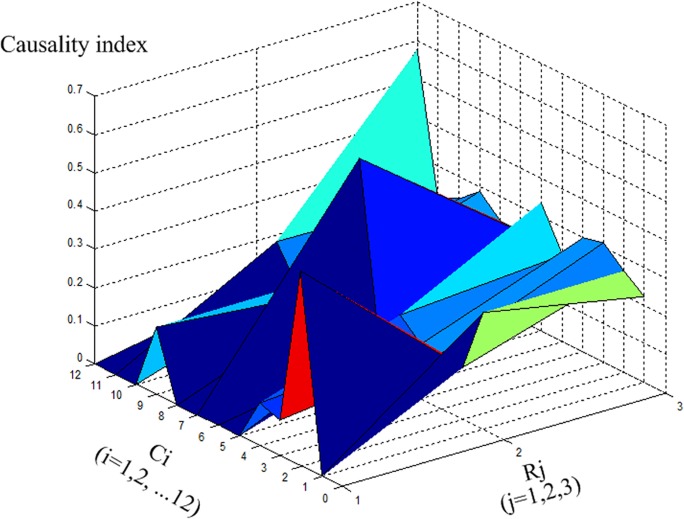
Causality index map.